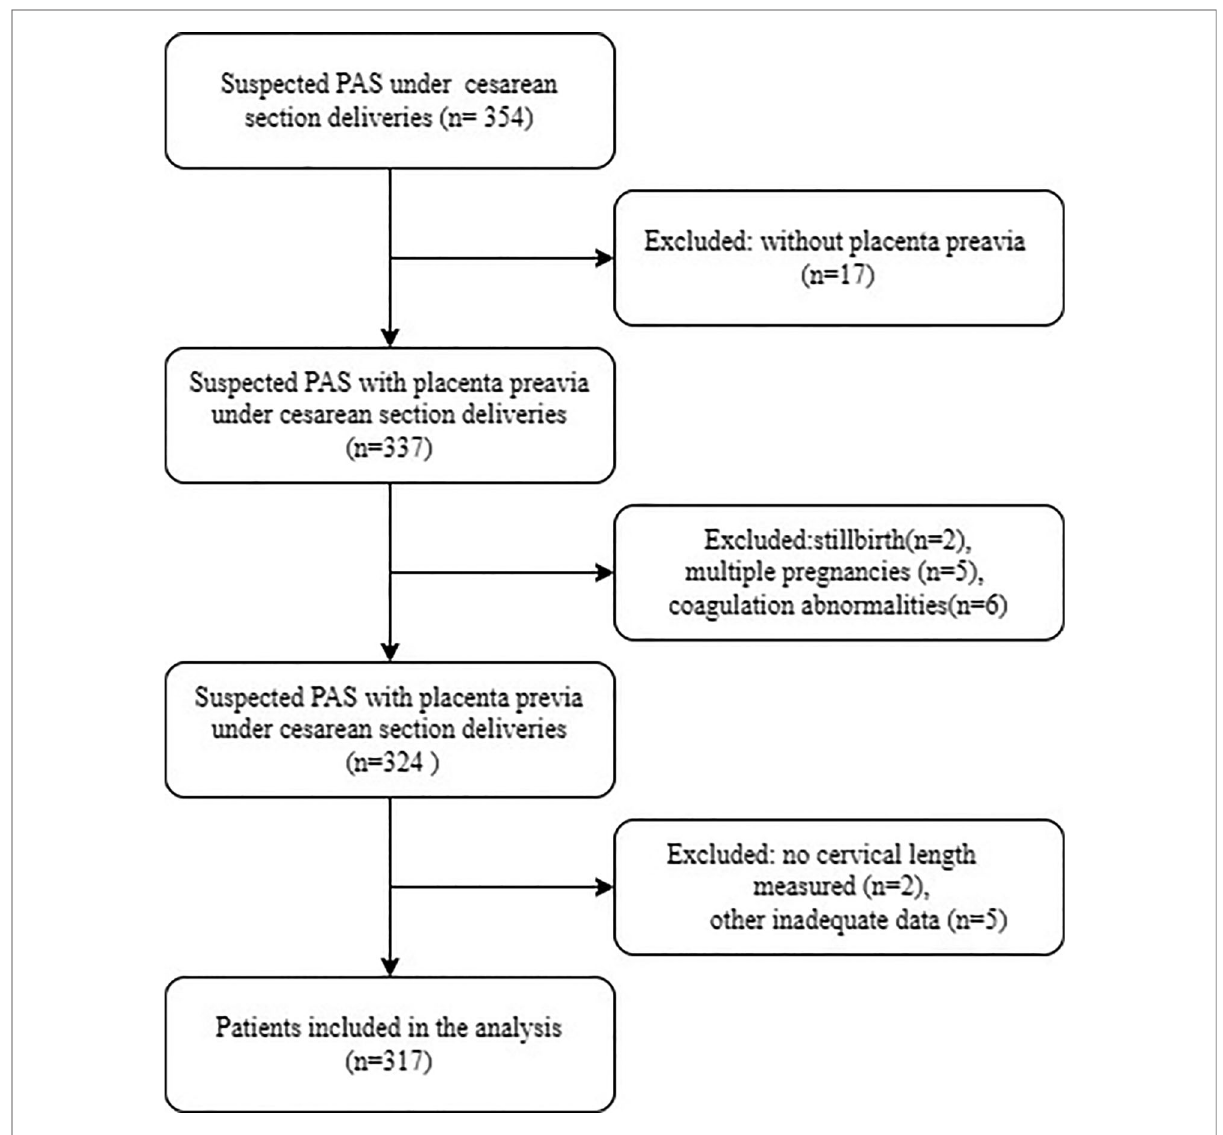
FIGURE 1 Flowchart showing the study population